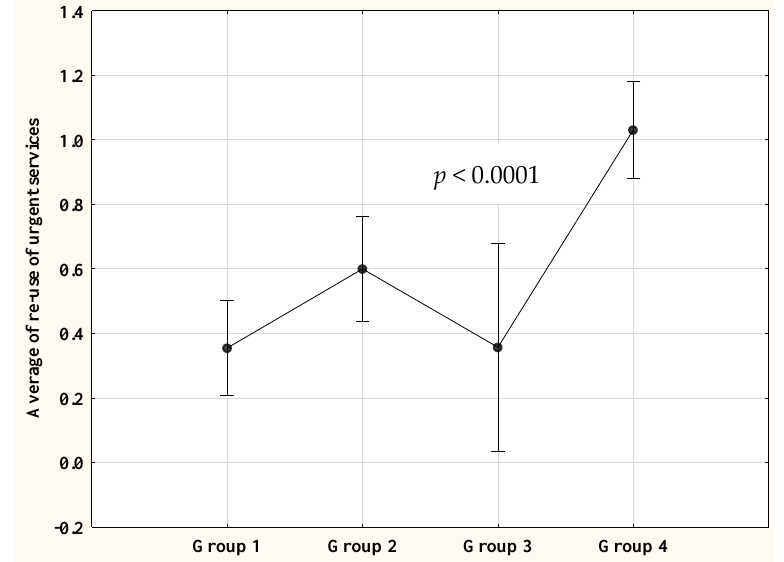
Figure 2. Group-based comparison of average number of revisits to the emergency department (ED) with and without hospital admission within a year after discharge. Group 1: white children with private insurance; Group 2: white children with public insurance; Group 3: nonwhite children with private insurance; Group 4: nonwhite children with public insurance; vertical bars denote 95% confidence interval.